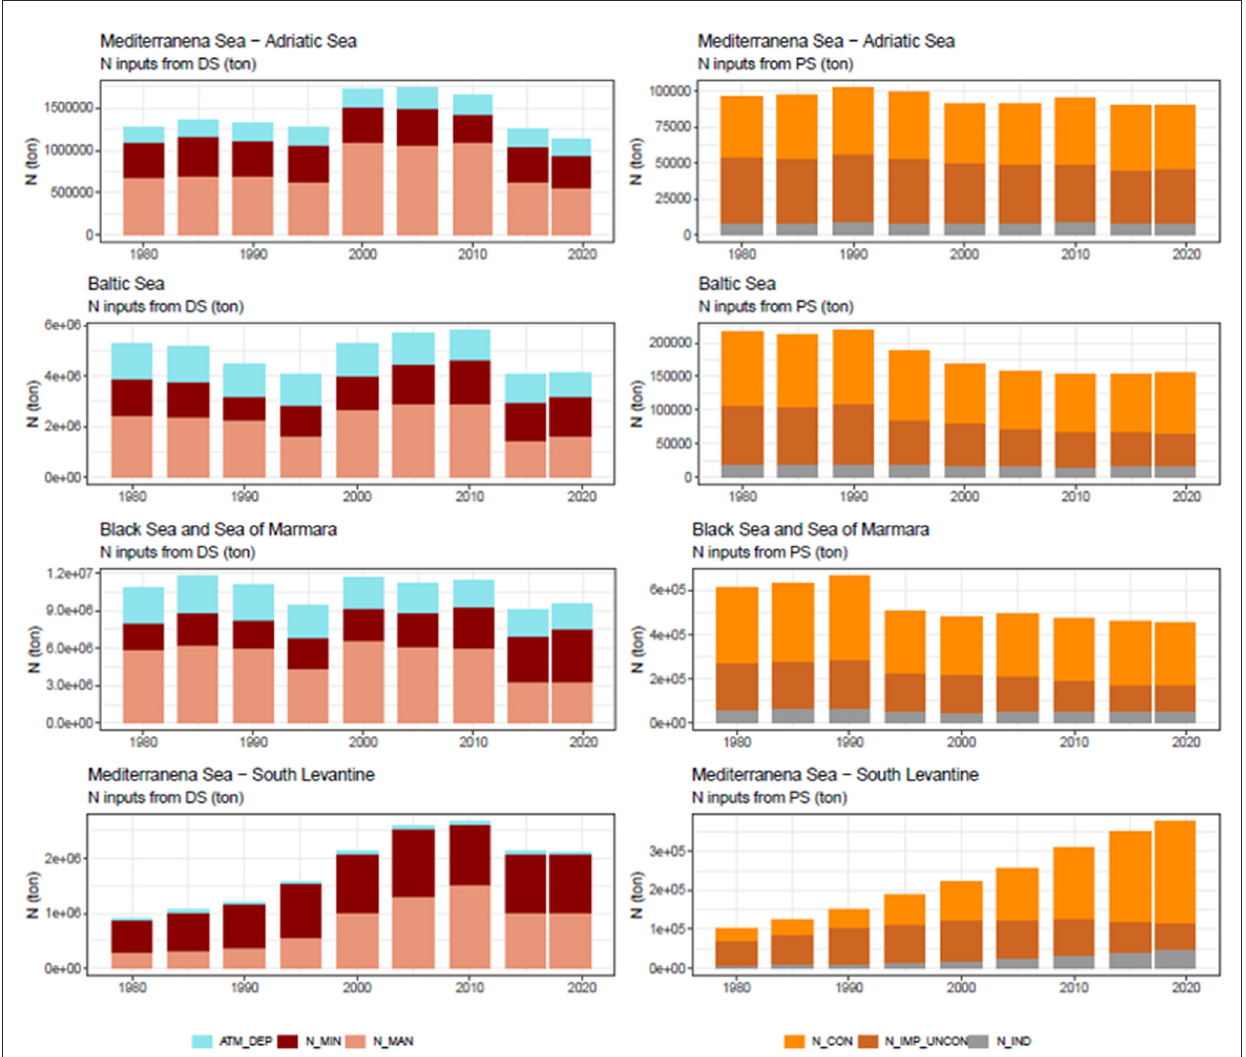
FIGURE4 Nitrogen inputs (ton) by selected marine regions in the study area. On the left , diffuse sources: ATM_DEP atmospheric deposition, N_MIN nitrogen mineral fertilizer, and N_MAN nitrogen manure; on the right , point sources: N_CON nitrogen emissions collected in sewerage systems; N_IMP_UNCON nitrogen emissions from other systems that are not connected from sewerage systems; and N_IND nitrogen contribution from industrial discharges.